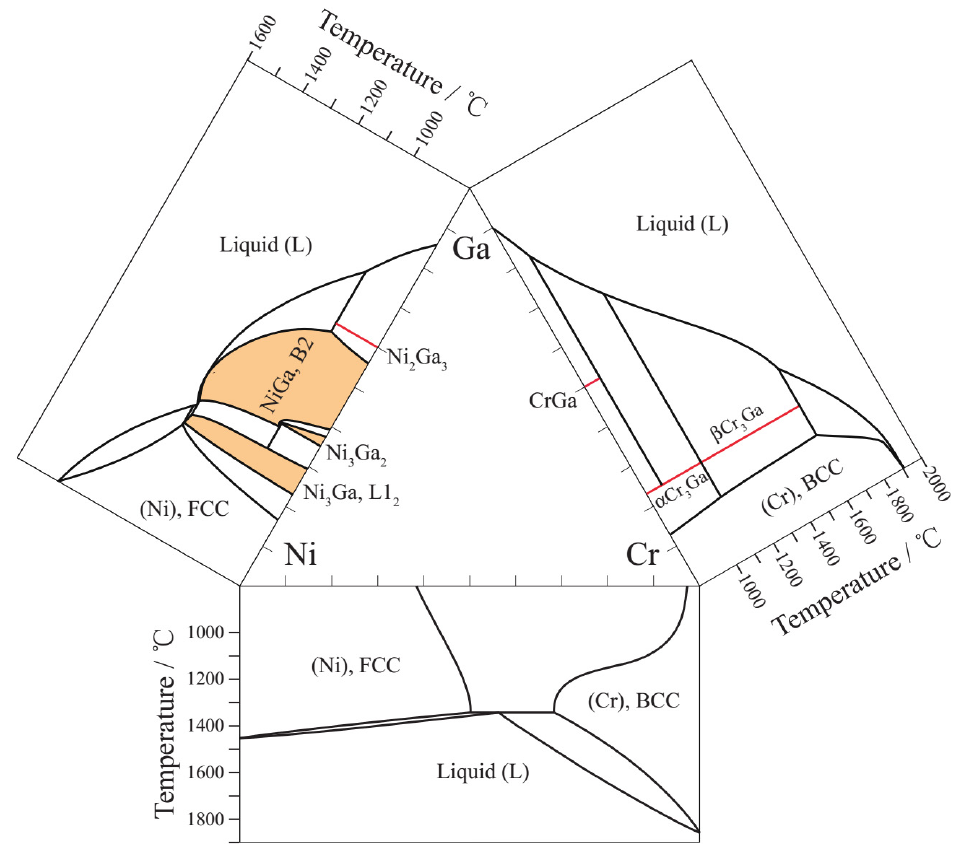
Figure 1. Binary phase diagrams constituting the Ni-Ga-Cr ternary system, and the intermetallic compounds are painted with color.